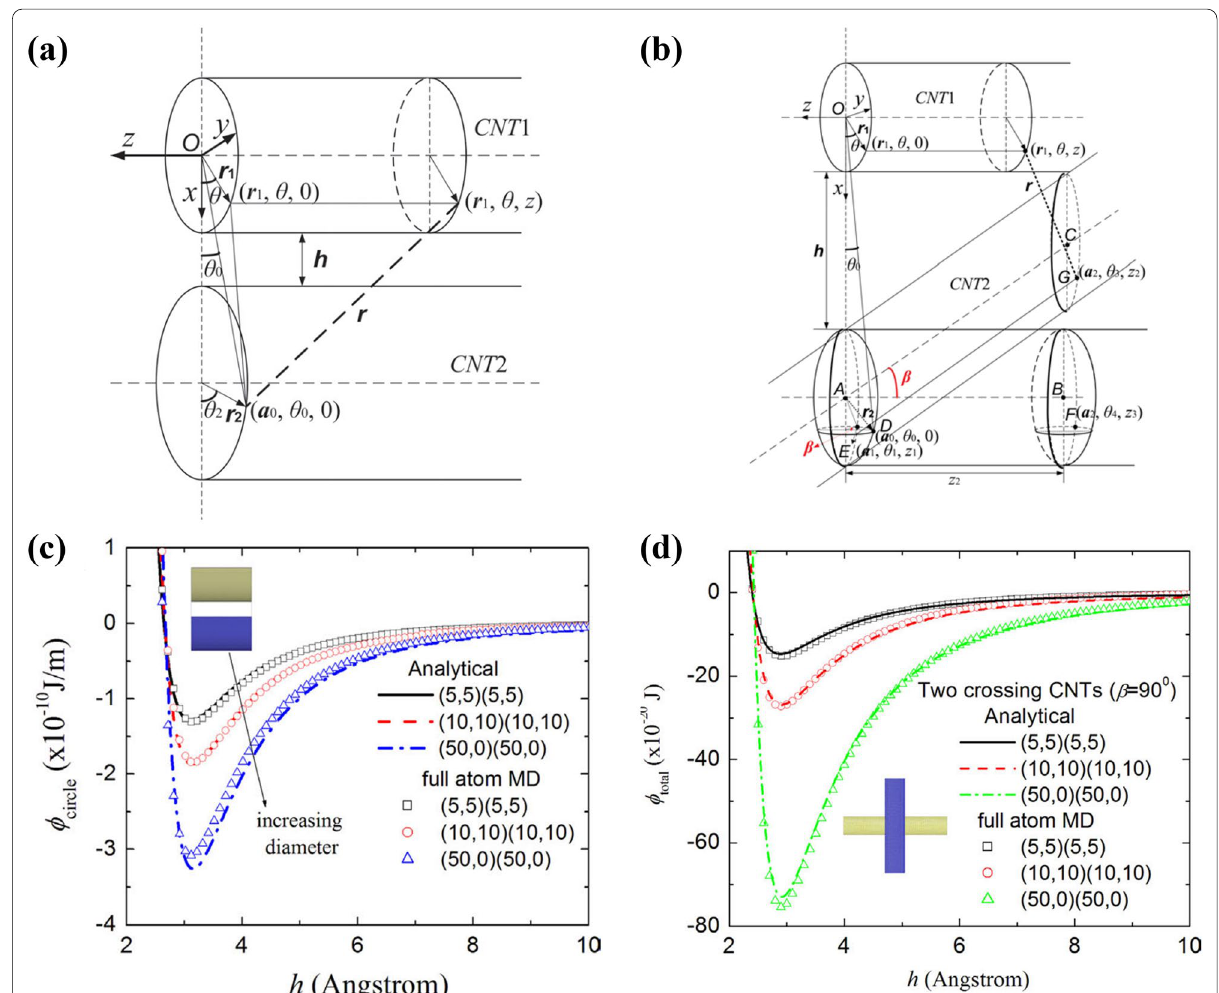
Figure 7 The coordinate system of ( a ) the two parallel infinite CNTs and ( b ) the two crossing infinite CNTs. The distribution of cohesive energy with different distance between ( c ) two parallel infinite CNTs and ( d ) two crossing infinite CNTs